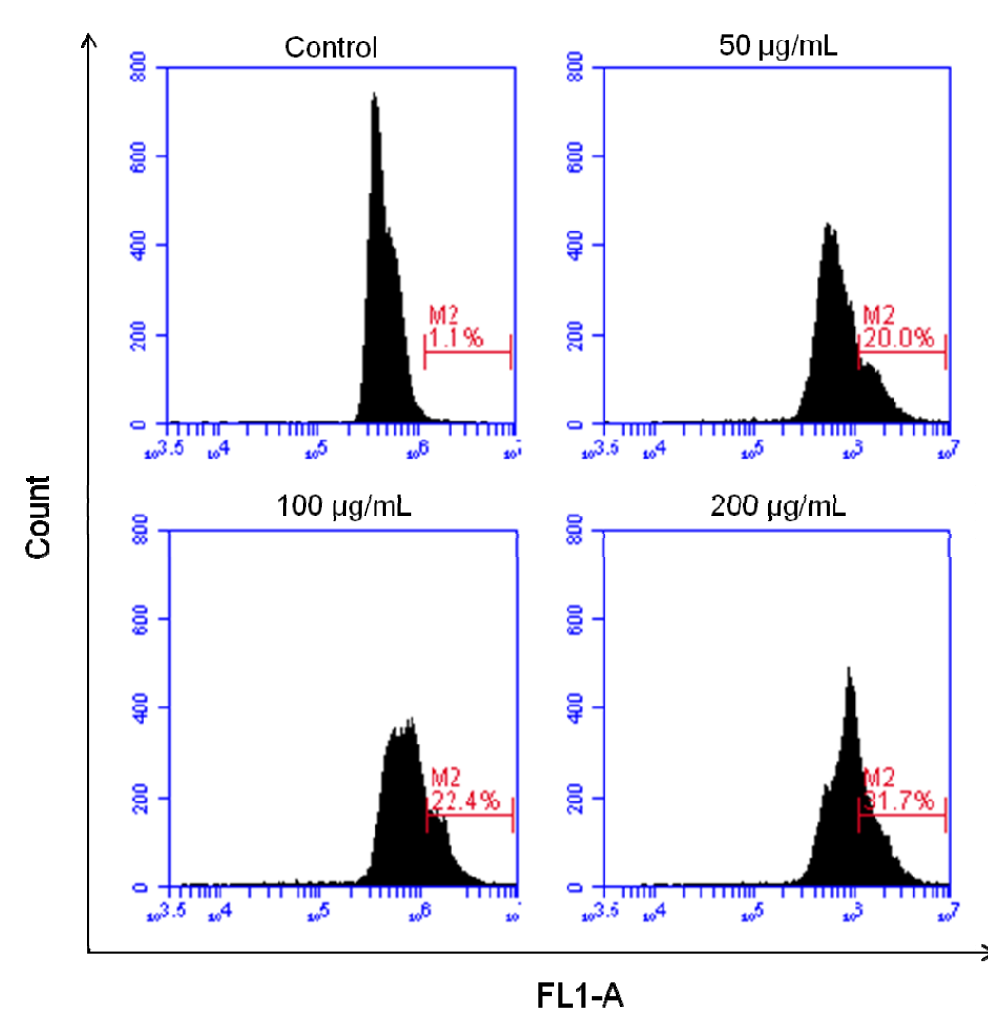
Figure 3. Effect of NRAF on DNA fragmentation of HT-29 cells. HT-29 cells were treated with different concentrations of NRAF (50 µg/mL, 100 µg/mL and 200 µg/mL) at 24 h incubation period. Positive TUNEL staining was shown by the M2 region in which cells were stained with FITC-conjugated anti-BrdU antibody. Histograms are representatives of three separate experiments (n =